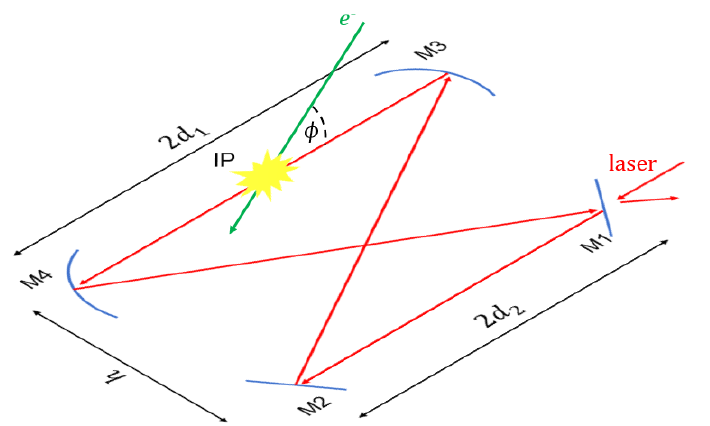
Figure 4. Schematic of Fabry–Pérot cavity of the XLS source. M1 and M2 are planar mirrors, M3 and M4 are concave mirrors. The interaction of the electron with the laser beam is evidenced at the